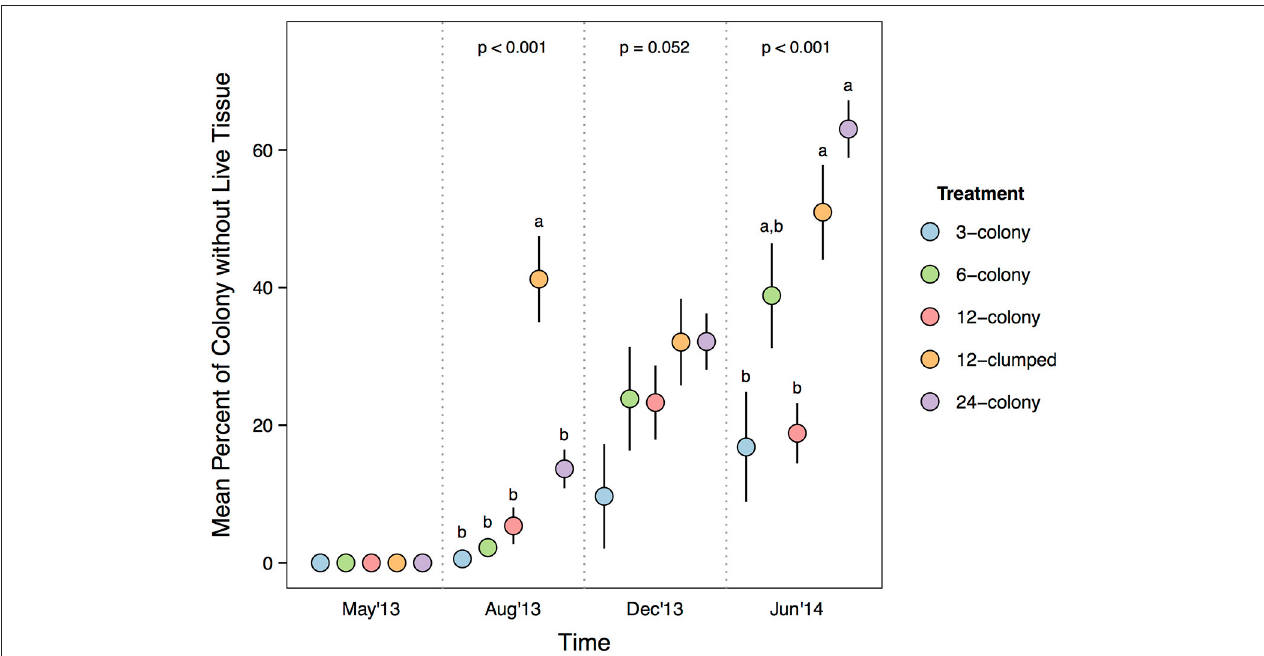
FIGURE 4 | Percent of each coral colony without live tissue compared among treatments within each survey period. P -values for each survey period are from Kruskal-Wallis test. Letters represent significant differences ( p < 0.05) among treatments from post-hoc analysis comparing median percent of colony without live tissue values within a survey period. Data are means ± SE.